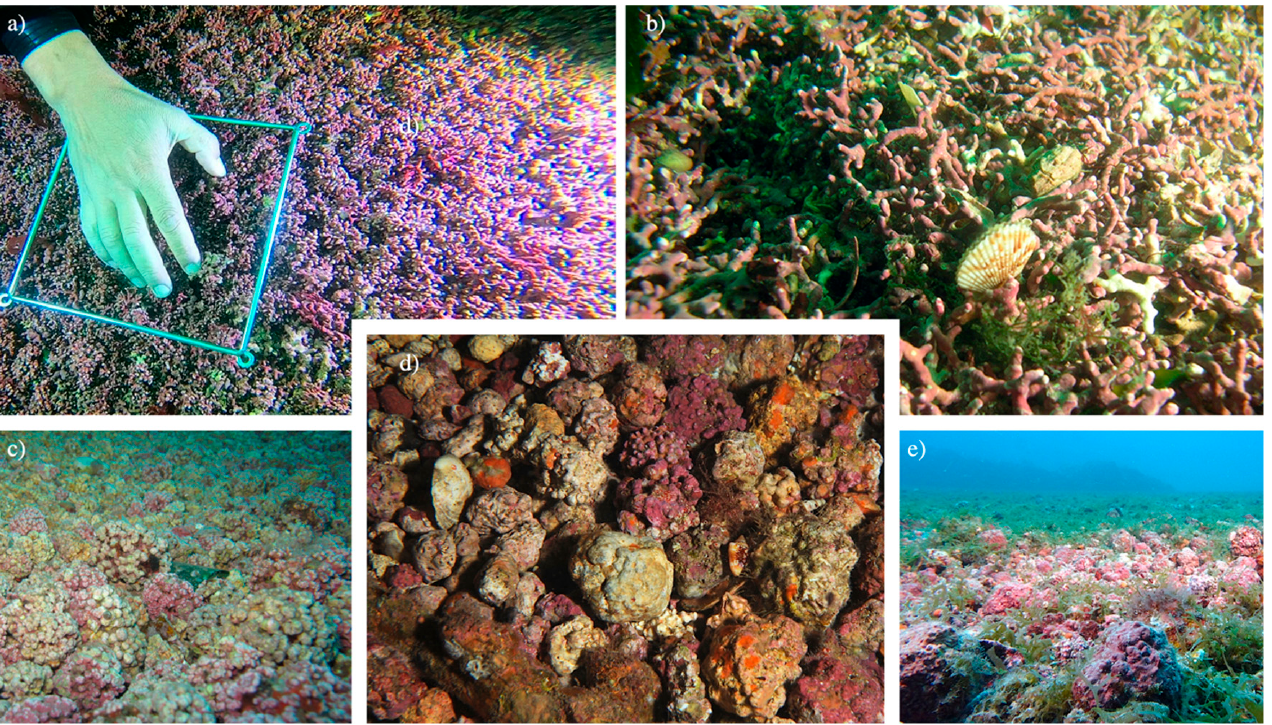
Figure 1. Rhodolith seabeds from ( a ) Brittany, ( b ) Galicia, ( c ) Madeira, ( d ) Gran Canaria, and ( e ) Principe Island. Photo credits: ( a , d ) Fernando Espino; ( b ) Ignacio Bárbara; ( c ) Pedro Neves, and ( e ) Francisco Otero-Ferrer.